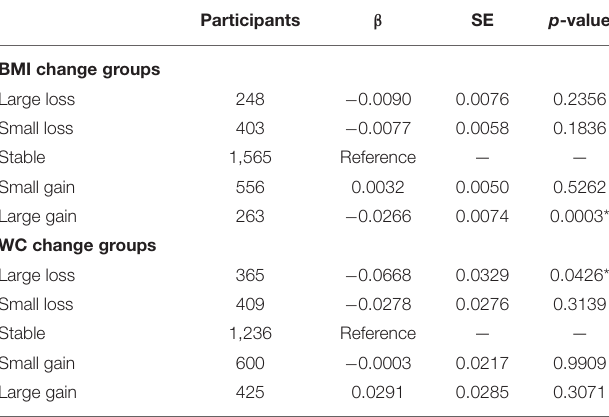
TABLE 5 | The association between global cognitive decline (SD per year) comparing quartiles of BMI and WC change.